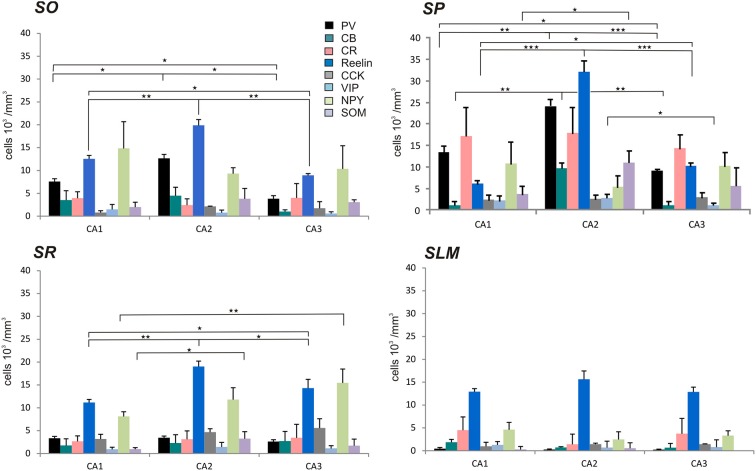
Densities of immunolabeled interneurons in all layers of the CA1, CA2, and CA3 regions. Cell densities of inhibitory cells (number of cell bodies per volume) that express parvalbumin (PV-black), calbindin (CB-turquoise), calretinin (CR-pink), Reelin (dark blue), cholecystokinin (CCK-gray), Vasoactive Intestinal Peptide (VIP-light blue), Neuropeptide Y (NPY-green), and somatostatin (SOM-purple) in stratum oriens (SO), stratum pyramidale (SP), Stratum radiatum (SR), and stratum lacunosum moleculare (SLM) of CA1, CA2, and CA3. There was a higher density of PV- and Reelin-positive neurons in SO in CA2 than in CA1 and CA3 (MWU P < 0.05). SP of the CA2 region contained a higher density of PV-, Reelin- and CB-positive interneurons than in CA1 and CA3 (MWU P < 0.05). There were also a higher number of VIP-positive somata in SP in CA2 than in CA3 and a larger density of SOM-positive cells in SP in CA2 than in CA1 (MWU P < 0.05). A higher density of Reelin- and SOM-positive neurons was found in SR in CA2 than in CA1 (MWU P < 0.05). *P = 0.01 to 0.05; **P = 0.001 to 0.01; ***P < 0.001.